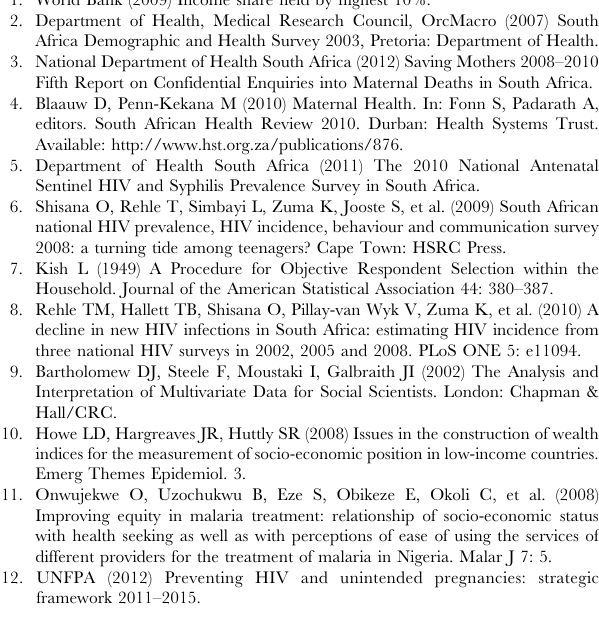
Table S1 Inequities in maternal health across different popula- tions groups in South Africa: analysis of the 2008 national SABSSM